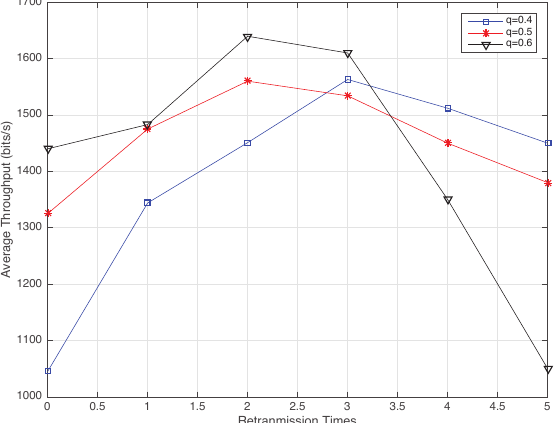
Figure 6. The average throughput versus the number of retransmission times under different mean arrival rates q